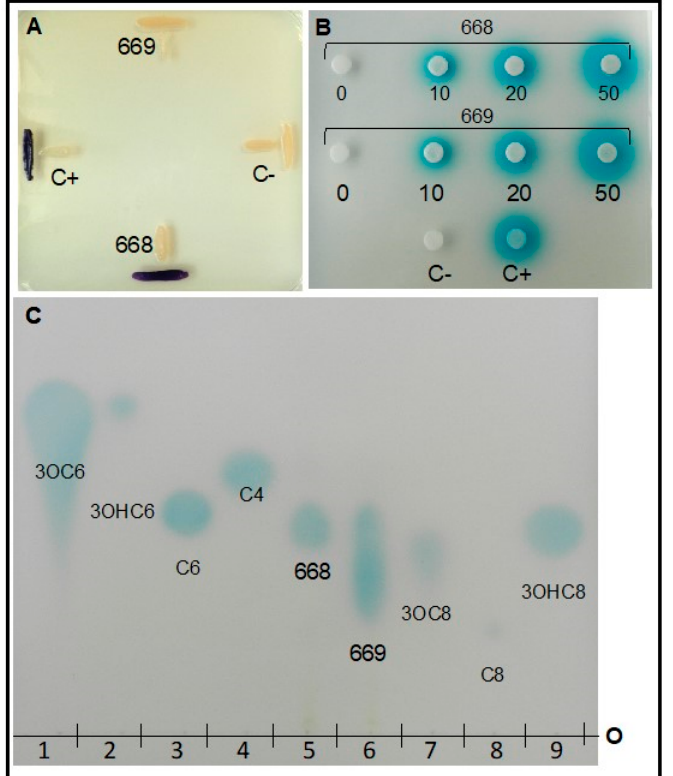
Figure 4. Quorum sensing signals of the acyl-homoserine lactone (AHL) class are produced by A. hydrophila RIT668 and C. portucalensis RIT669. Three formats using two complementary AHL-dependent whole cell biosensor strains were used, Chromobacterium violaceum CV026 (panel A ) and Agrobacterium tumefaciens NTL4 (pZLR4) (panels ( B , C )) [70]. T-streak bioassay using biosensor CV026 (A) C + strain, DH5a (pT140A) and C − strain, CV026. Disc-di ff usion bioassay